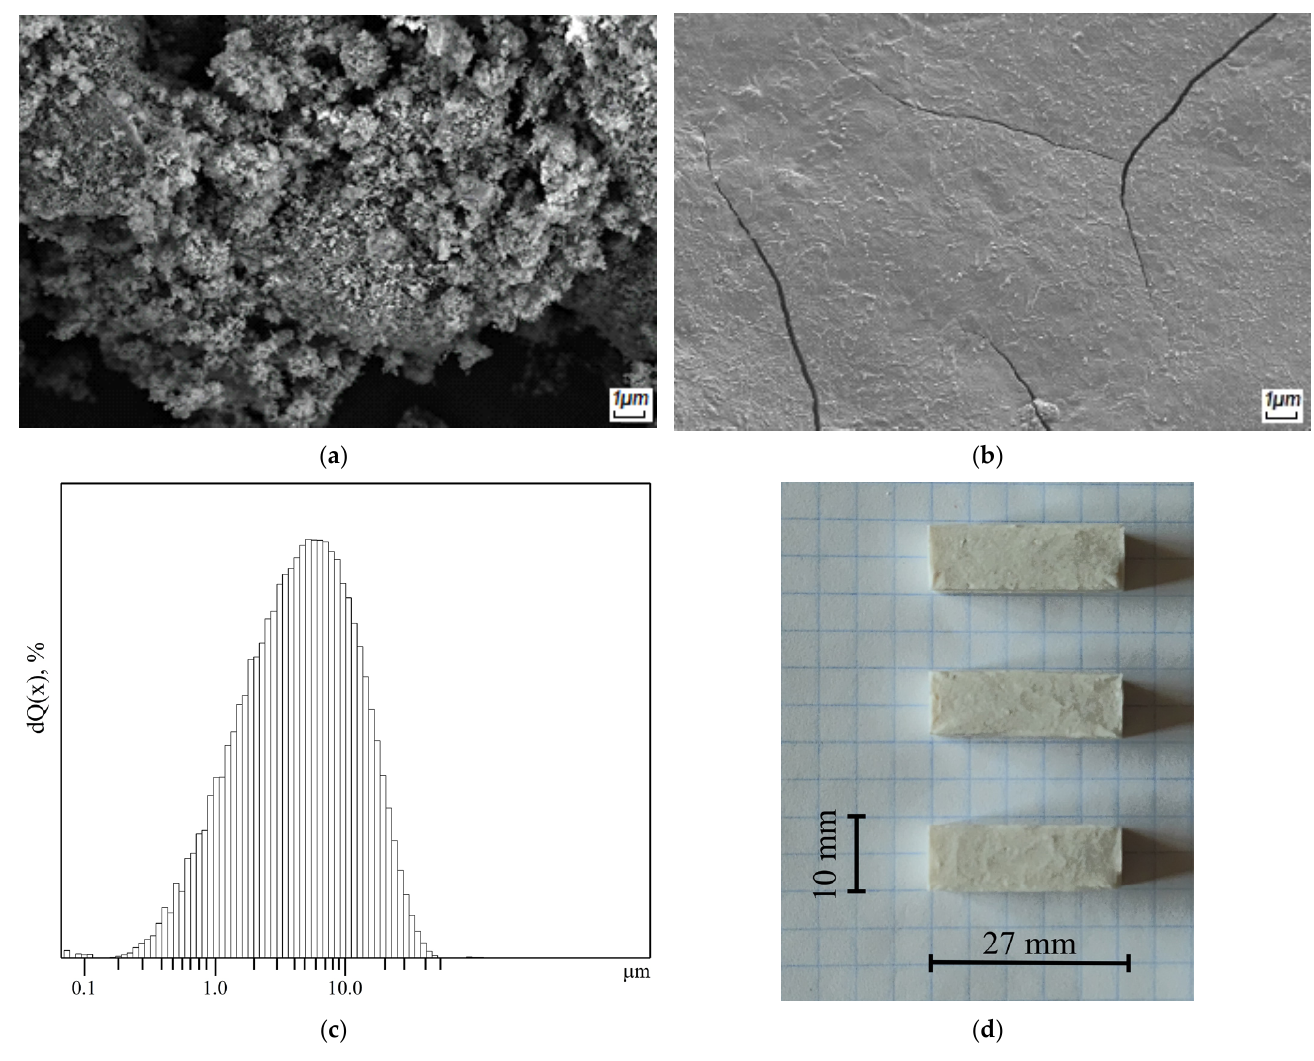
Figure 2. SEM images of the hydroxyapatite powder before ( a ) and after mixing with the aqueous solution of sodium silicate and drying at 60 ◦ C for 24 h ( b ). Particle size distribution of commercial hydroxyapatite (SigmaAldrich) ( c ). Image of the pre-ceramic sample based on the hydroxyapatite powder and the aqueous solution of sodium silicate after demolded and drying at 60 ◦ C for 24 h ( d